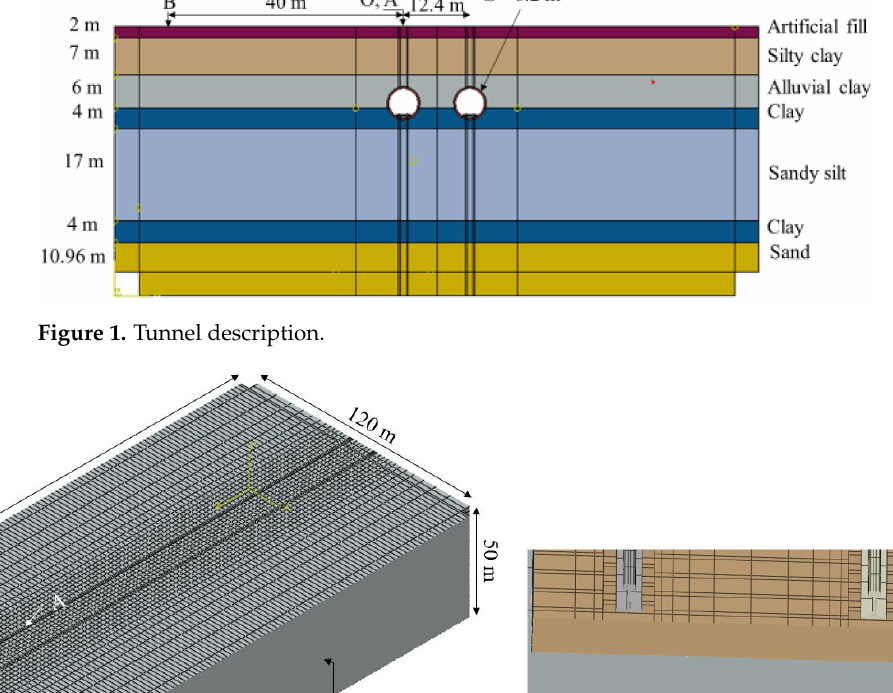
Figure 1. Tunnel description.